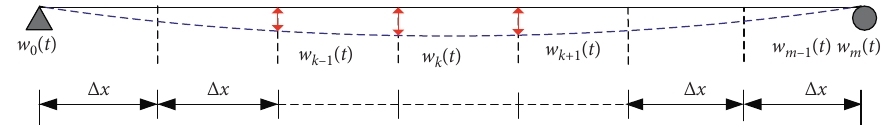
Figure 11: Segment division of the beam.